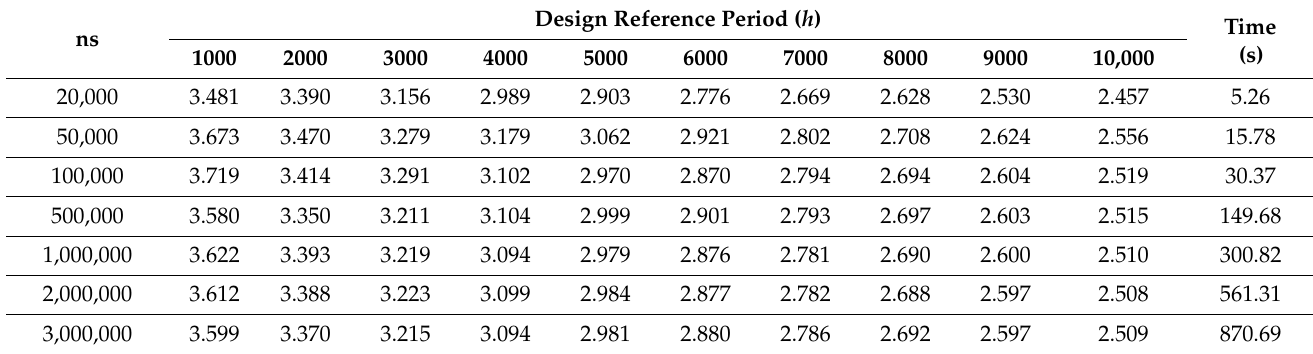
Table 1. Calculation results of Monte Carlo method under different sample numbers.